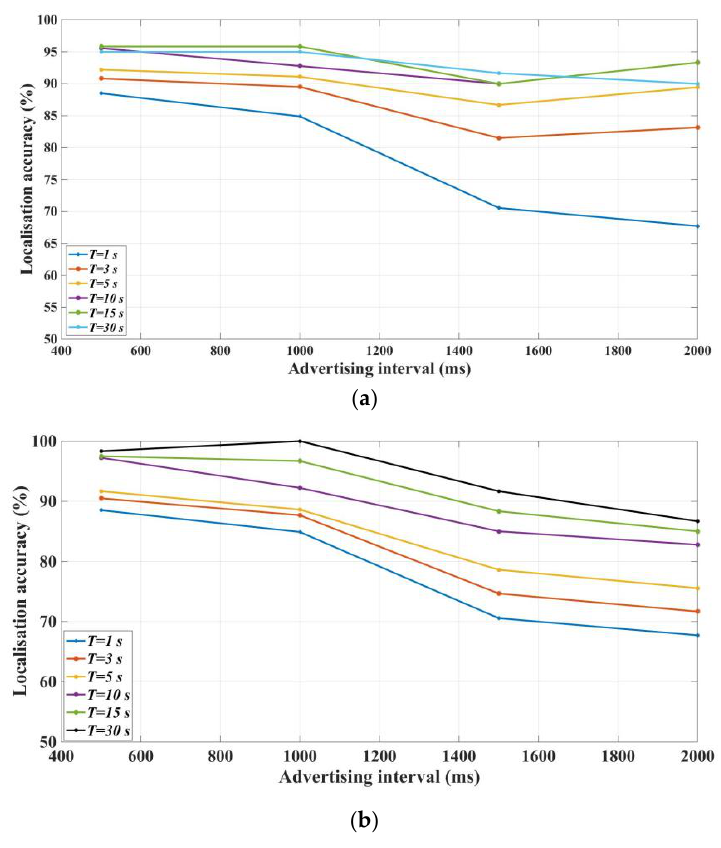
Figure 7. Impact of the advertising time interval on localization accuracy: ( a ) p - RSSI index; ( b ) m - RSSI index.